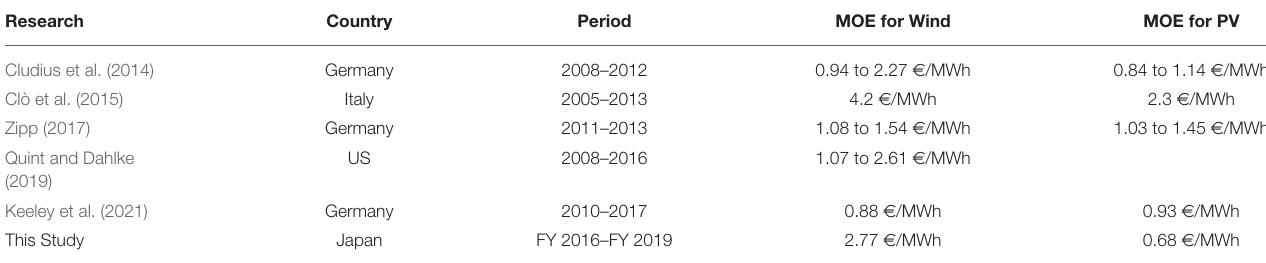
TABLE 5 | The MOE for each GWh of additional VRE generation. Research